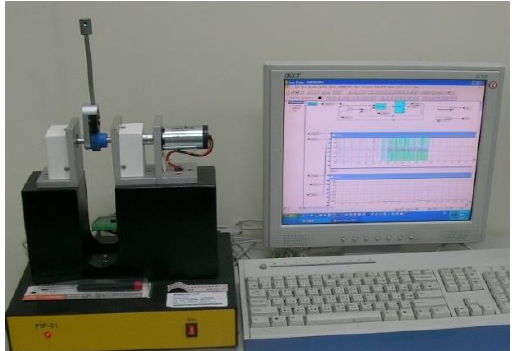
Figure 11. A real control system of planetary train inverted pendulum.